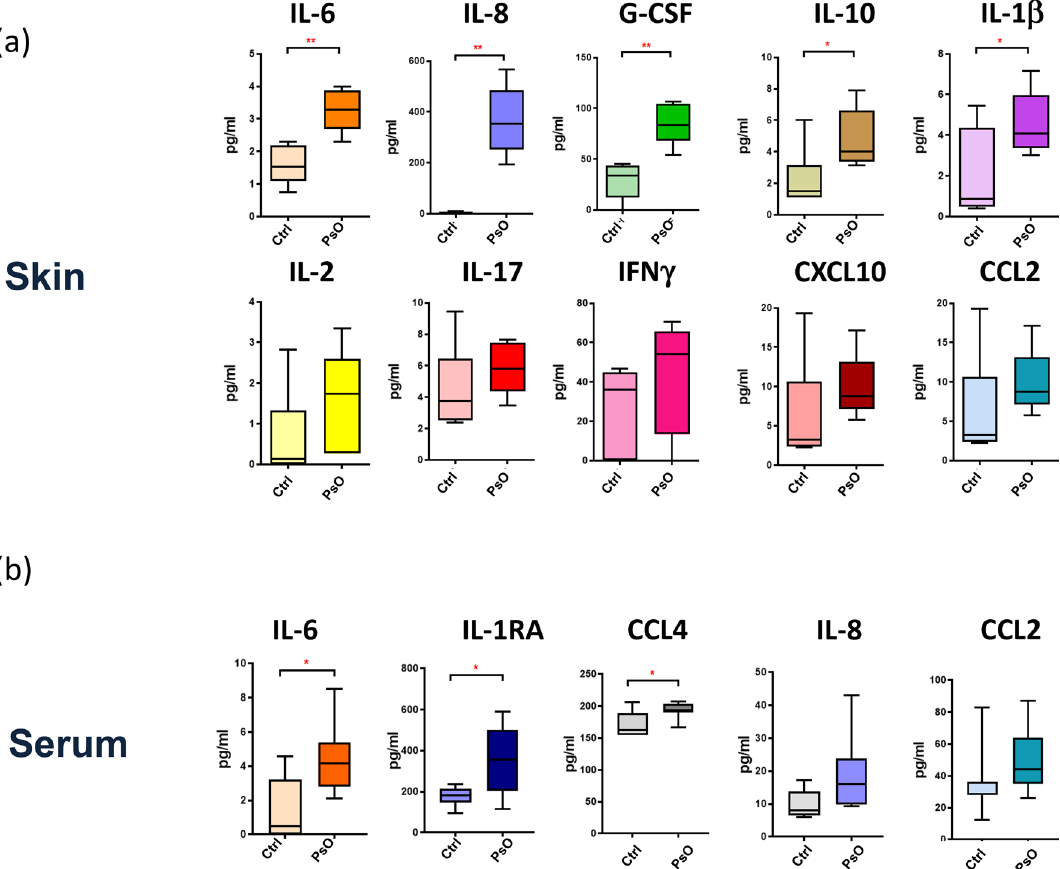
Figure 3. Cytokine and chemokine concentration (pg/ml) in skin ( a ) and serum ( b ) samples is represented as Box and Whisker Plot. Significance of the differences between psoriasis patients’ and healthy subjects’ control group was calculated using Student’s t-test for unpaired samples or Mann–Whitney test depending on the normality of data distribution. p < 0.05 was considered significant: *p < 0.05. **p < 0.01. Figure produced